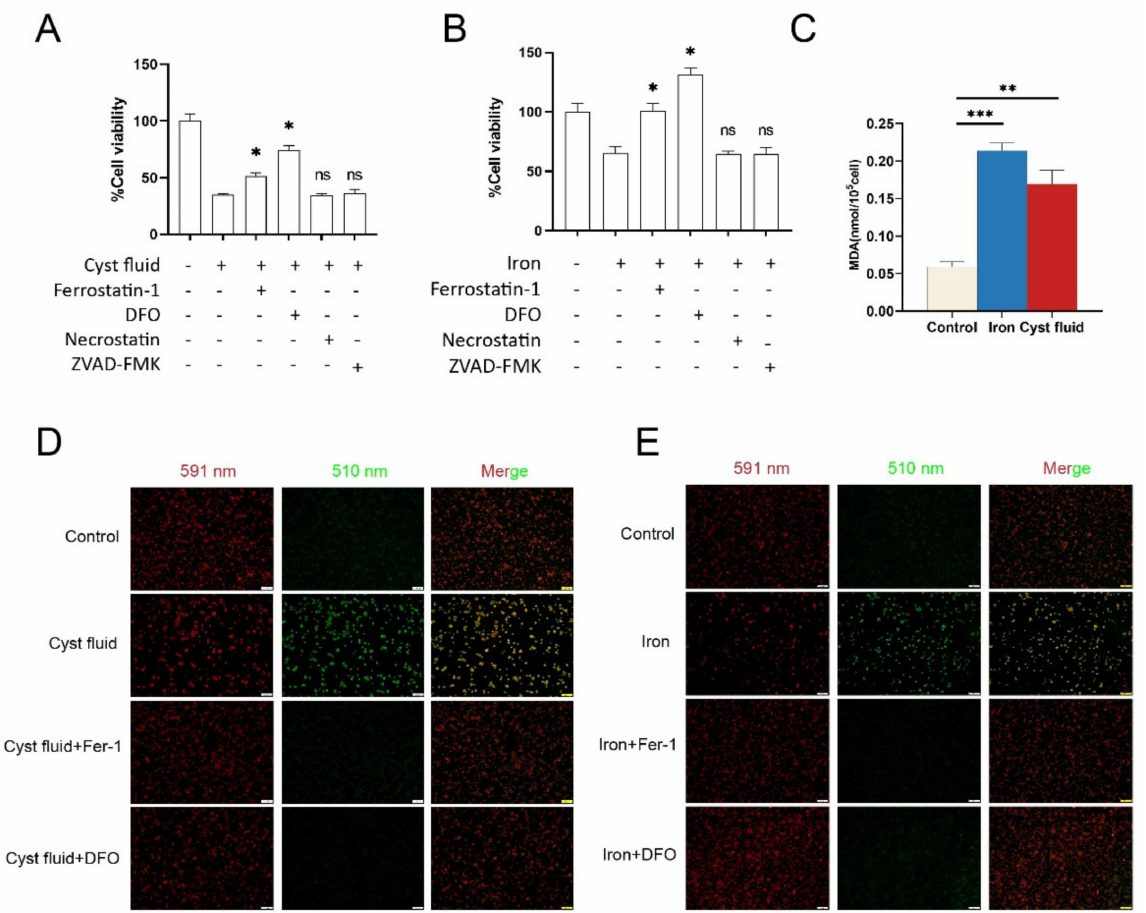
Figure 3. Cyst fluid-induced iron-dependent ferroptosis in macrophages. ( A , B ) PMA-stimulated THP-1 cells were treated with 2% cyst fluid or 200 µ g/mL FeSO 4 solution in the absence or presence of the indicated bioactive inhibitors (ferrostatin-1, 10 µ M; DFO, 200 µ M; necrostatin, 2 µ M; ZVAD- FMK,5 µ M) in 96-well plates for 24 h. Cell viability was measured with CCK-8 (* p < 0.05 vs. cyst fluid or FeSO 4 ). ( C ) Intracellular MDA levels in THP-1 cells treated with 2% cyst fluid or 200 µ g/mL FeSO 4 solution. ( D , E ) Representative images of C11-BODIPY (581/591) staining in THP-1 cells with different treatments (cyst fluid,2%; FeSO 4 solution, 200 µ g/mL; ferrostatin-1, 10 µ M; DFO, 200 µ M). 591nm shows the reduction state, and 510 nm shows the oxidation state. Scale bar =100 µ m. Fer-1: ferrostatin-1; DFO: deferoxamine. * p < 0.05, ** p < 0.01, *** p <